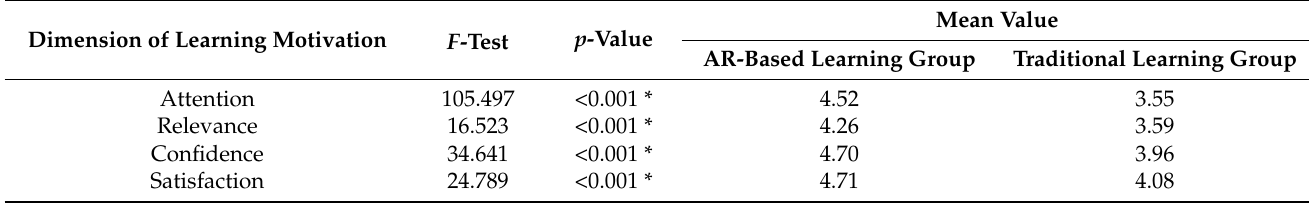
Table 8. Level of significance for the four dimensions of learning